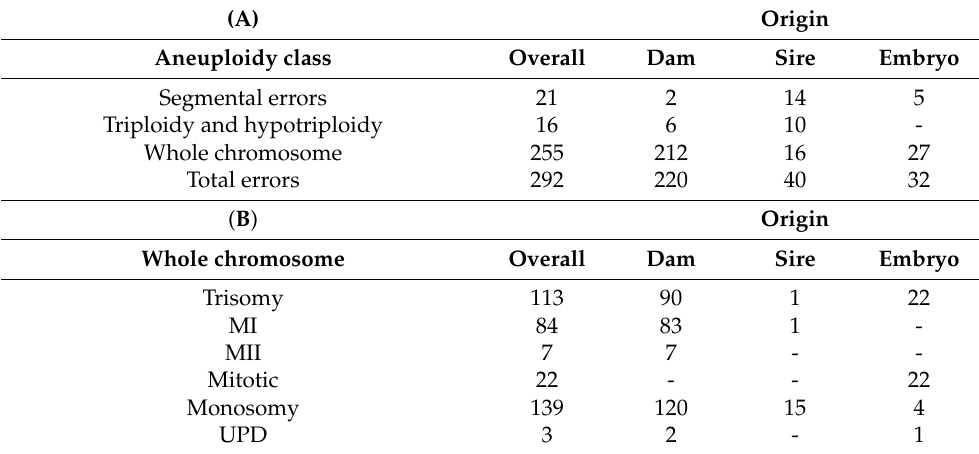
Table 2. Chromosomal abnormality class and frequency as identified by PGT-A. ( A ) Overview of all chromosomal errors detected, including a breakdown by error class and origin (maternal germline, paternal germline, embryonic). ( B ) Detailed overview of whole chromosome errors, providing a breakdown of error class (monosomy, trisomy, uniparental disomy (UPD)) and its origin; for